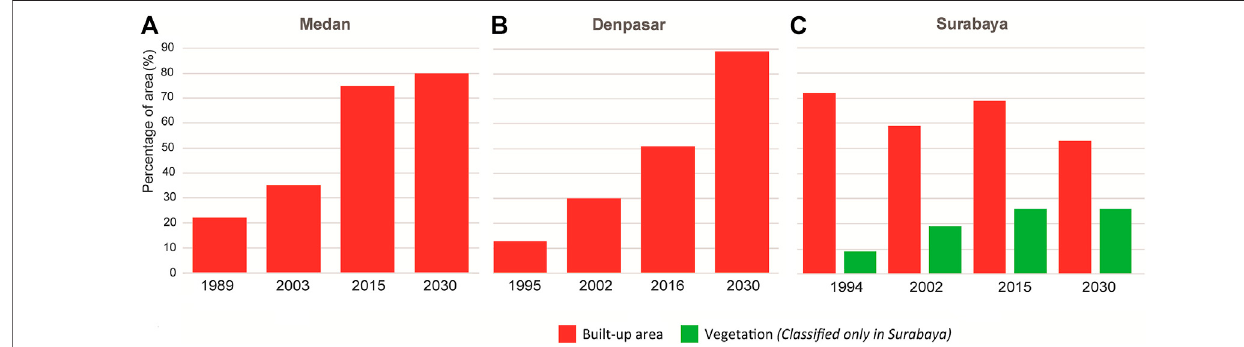
FIGURE 6 | Land cover change in (A) Medan, (B) Denpasar, and (C) Surabaya.